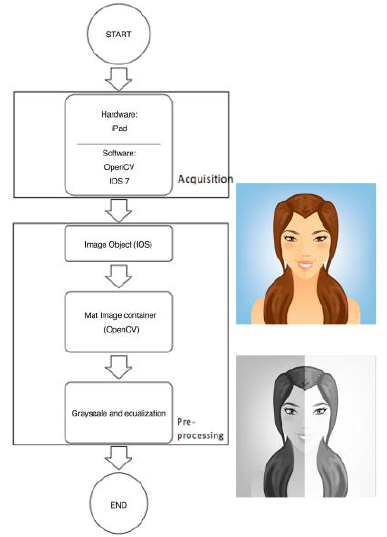
Figure 4. Low-level diagram of first